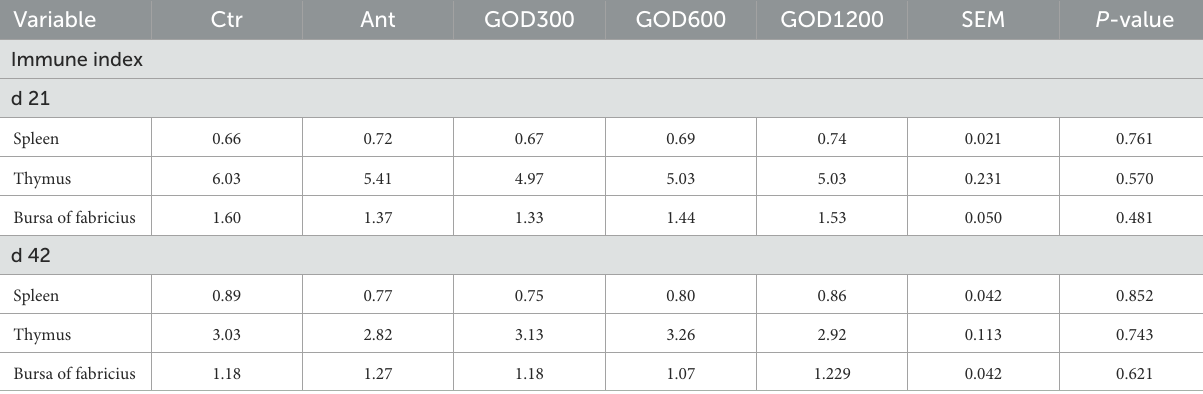
TABLE 4 Effect of GOD on relative weights of immune organs of broilers (mean ± SEM, n = 6). Variable